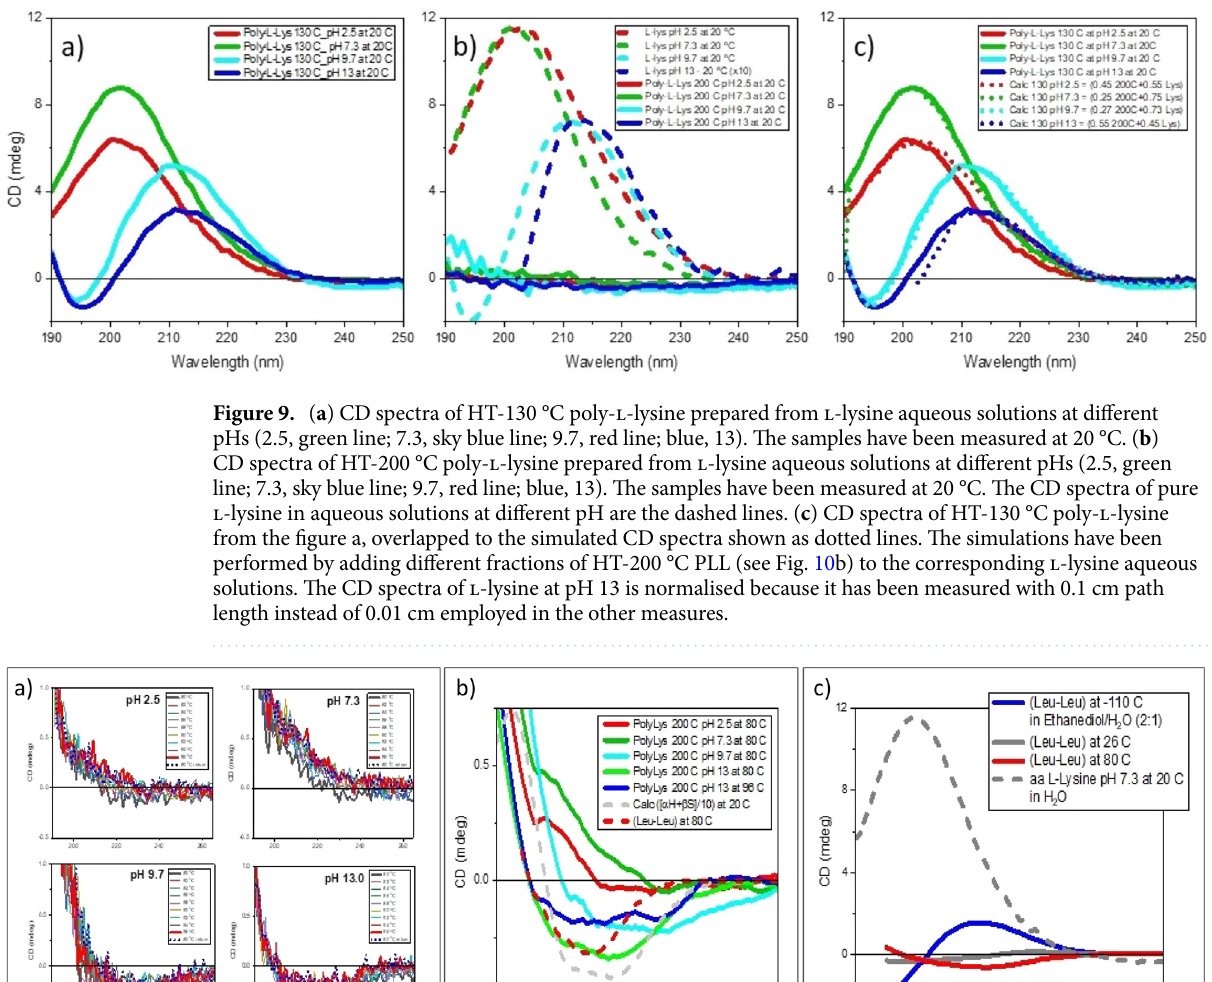
α-helix conformation. The different intensities of the two bands suggest that the β-strand is the predominant conformation that l-lysine assumes when it polymerizes starting from a high pH solution. The α-helix is more difficult to form and should be present to a lesser extent. Circular dichroism (CD) analysis has been employed to support the FTIR findings and get a more detailed analysis of the spatial arrangement in the different PLL structures. (Fig. 9). Figure 9a shows the CD spectra of HT-130 °C PLL prepared from different pHs and measured at 20 °C. The CD spectra measured for the samples from lower pHs (2.5 and 7.3) show positive band maxima at 200 nm that red shift to 210 nm for pH 9.7 and 13 PLLs (Fig. 9a). These spectra are not resembling any of the conformations that a-poly-l-lysine is capable of adopting, such as α-helix, β-strand, poly proline of type II (PII), and unordered conformations 22 . On the other hand, in the case of an ε-poly-l-lysine polymer, the amide bonds are isolated, quite far from each in the structure, and do not couple like in the α-poly-l-lysine generating the characteristic canonical CD shapes of secondary structure protein conformations. The HT-200 °C PLLs, measured at 20 °C, show, however, featureless CD spectra of very negligible intensity for all the pHs (Fig. 9b), indicating spectral cancellation. This effect is shown in Fig. 10c for the dipeptide Leucyl- Leucine at 20 °C used as model. Conformations of the opposite sign, like those assigned to left-handed extended